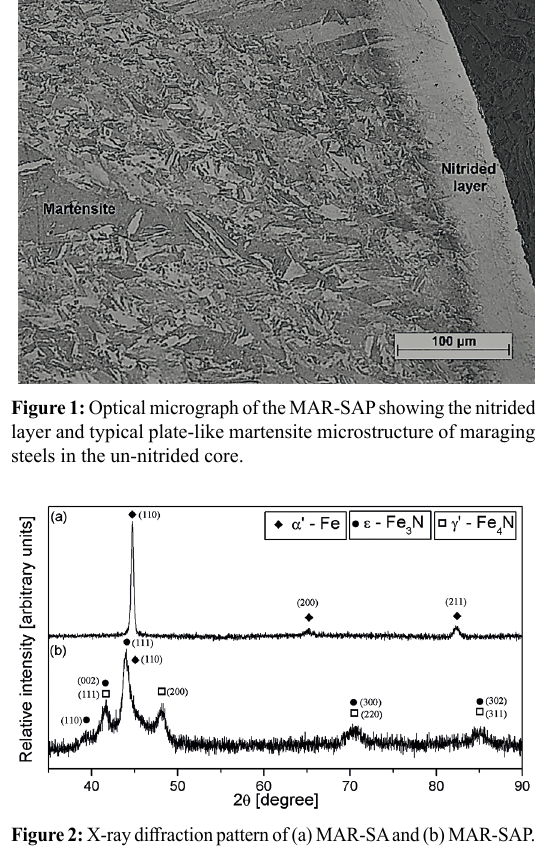
Figure 5: Creep curves of MAR-SA 18 and MAR-SAP at 650 ºC and 200 MPa. Table 2: Creep data of MAR-SA 18 and MAR-SAP at 650